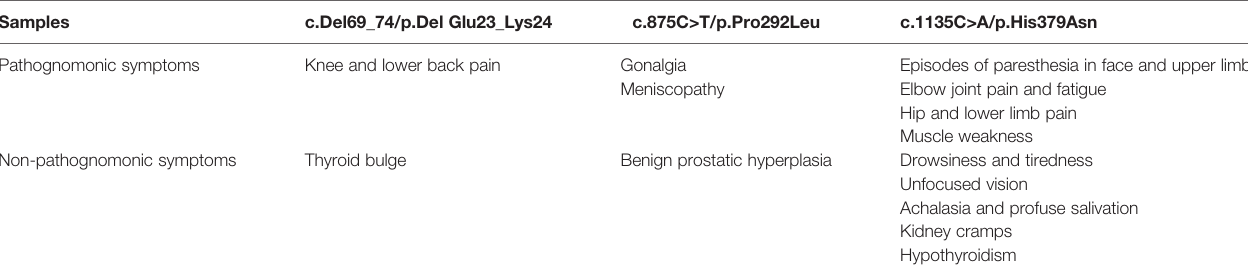
TABLE 2 | Clinical manifestations of patients affected with variants of uncertain signi fi cance of ALPL gene. Samples